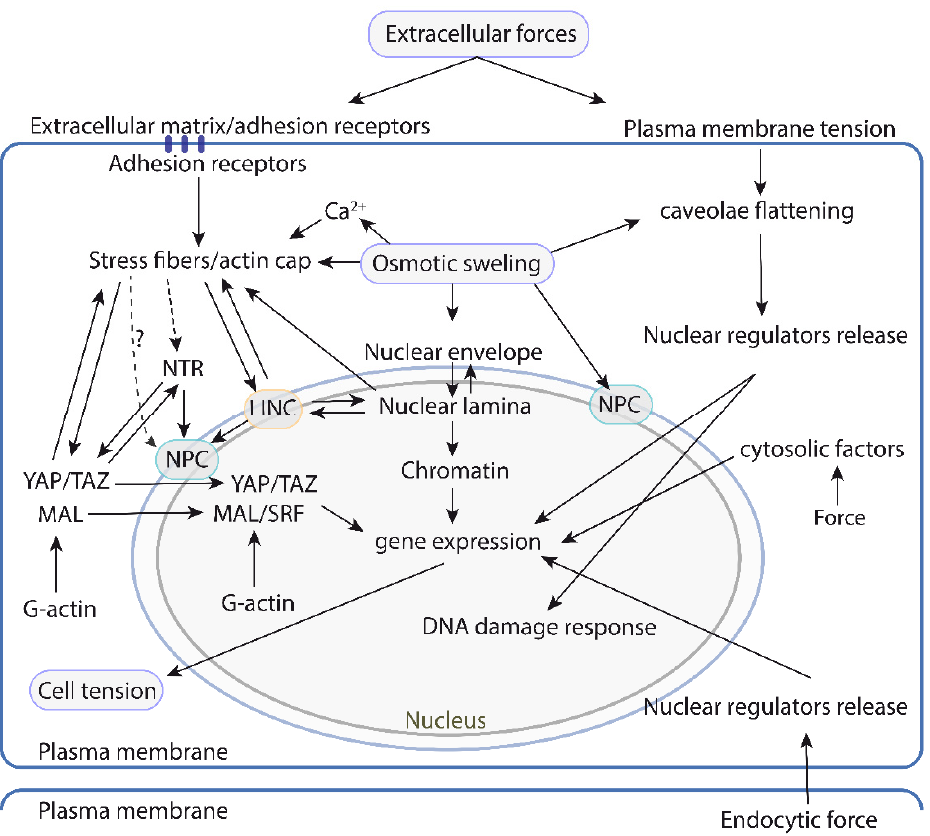
Figure 6. A map of the physical and/or functional interactions between the different mechanosensi- tive or mechanoresponsive cell structures and pathways controlling nuclear mechanotransduction and function. The left side focuses on the pathways that rely on the actin cytoskeleton and the LINC complex to transduce mechanical information to the nucleus. This system is relatively well understood, and the current understanding suggests that it is highly interconnected with different mechanosensitive structures throughout. The right side illustrates the pathways that operate independently of the actin cytoskeleton-LINC axis and respond to forces generated or sensed at the plasma membrane. Mechanoresponsive events in cytosolic organelles that transduce to the nucleus have also been described and are depicted on the right side. LINC: linker of nucleoskeleton and cytoskeleton. NPC: Nuclear pore complex. NTR: nuclear transport receptors.